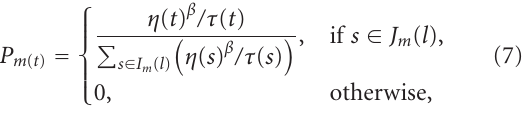
Figure 1: Flowchart of modified method of successive